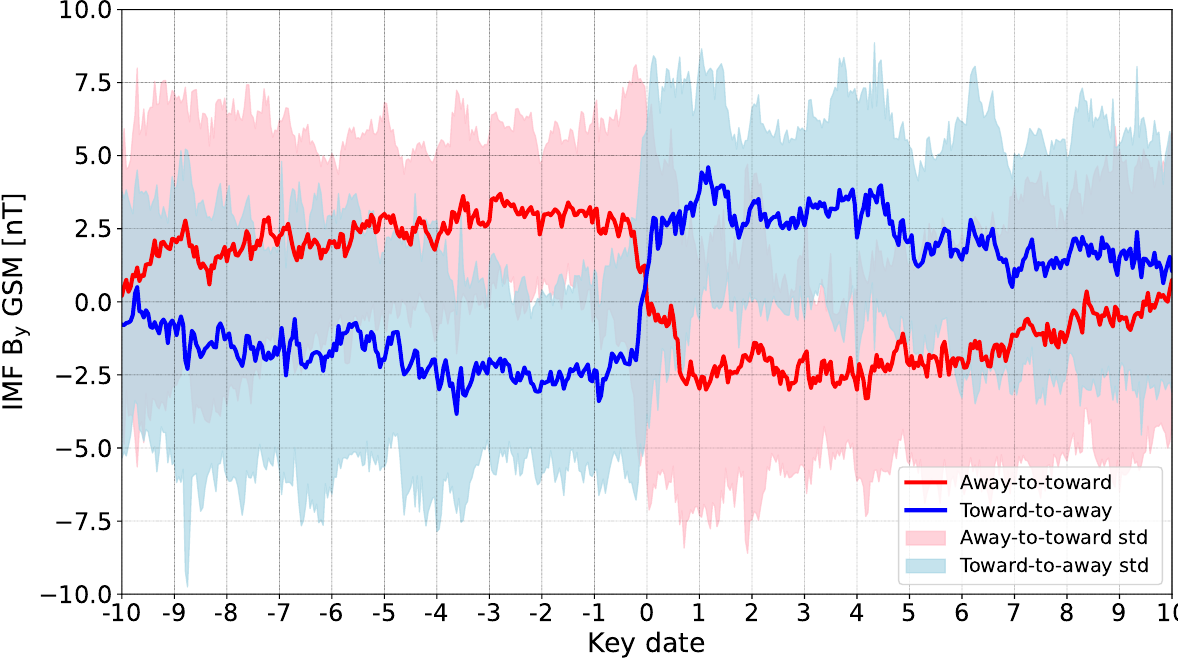
Figure 1. Superposed epoch analysis of the IMF B y around the HCS crossing for the period 1999–2002. Blue line: toward-to-away IMF B y change; Red line: away-to-toward IMF B y change. Shadings represent standard errors in the